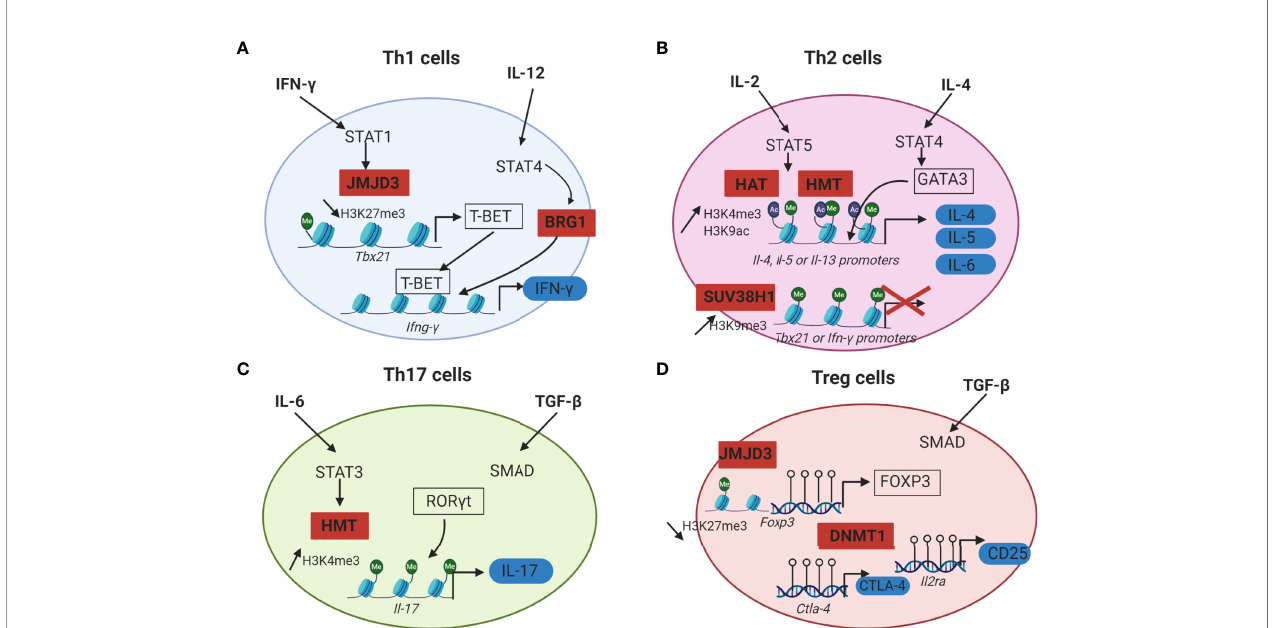
FIGURE 2 | Epigenetic mechanisms that regulate CD4 + T cells differentiation. For each CD4 + T cell subset, cytokines initiating Th cells differentiation are in bold, lineage speci fi c transcription factors are framed in black and effector proteins are surrounded in blue. Epigenetic enzymes regulating CD4 + T cells differentiation are in red squares. (A) IFN- g and IL-12 drive Th1 cells differentiation by inducing STAT1 and STAT4 activation. STAT1 recruits JMJD3 (H3K27me3 histone demethylases) at the promoter of Tbx21. This promotes the loss of the repressive mark H3K27me3 and allows T-BET expression. STAT4 induces the recruitment of a chromatin remodeling complex (BRG1) at the locus of Ifn- g which is responsible for a chromatin permissive to transcription. T-BET can then bind to the Ifn- g promoter and induce its transcription. (B) In Th2 cells, IL-2 signals through STAT5 and triggers the recruitment of HAT and HMT responsible for the increase of the permissive marks H3K9ac and H3K4me3 at Il-4, Il-5 and Il-13 gene loci. IL-4 plays a role in inducing STAT6 activation, which upregulates the expression of the master regulator GATA3. GATA3 can then bind to the promoters of Il-4, Il-5 and Il-13 and induce the transcription of these effector cytokines. In Th2 cells, Th1 associated genes are silenced by the HMT SUV39H1 which increases the repressive mark H3K9me3 at the loci of Tbx21 and Ifn- g and allows Th2 lineage stability. (C) During Th17 differentiation, IL-6 induces STAT3 activation and binding to the Il-17 promoter. STAT3 then recruits histone modi fi cation enzymes at the Il-17 locus, resulting in an increase of the permissive marks H3K4me3 and chromatin accessibility. ROR g t can thus bind to the Il-17 promoter and induce IL-17 expression. (D) Treg cells differentiation from naïve CD4 + T cells requires TGF- b . The expression of the master transcription factor FOXP3 as well as the immune checkpoint CTLA-4 and the IL-2RA (CD25) is dependent of DNA demethylation at the loci of these genes by DNMT1. Empty circles on DNA: unmethylated CpG